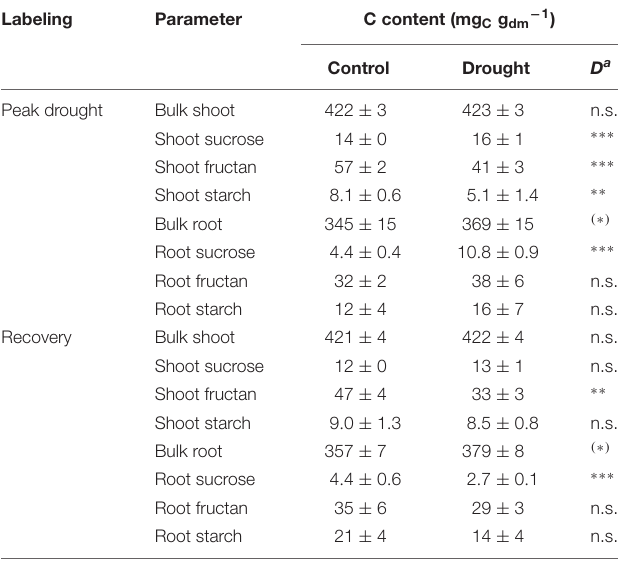
TABLE 2 | Effects of drought on the sizes of plant bulk and carbohydrate pools for the peak drought and the recovery labeling campaigns. Labeling Parameter